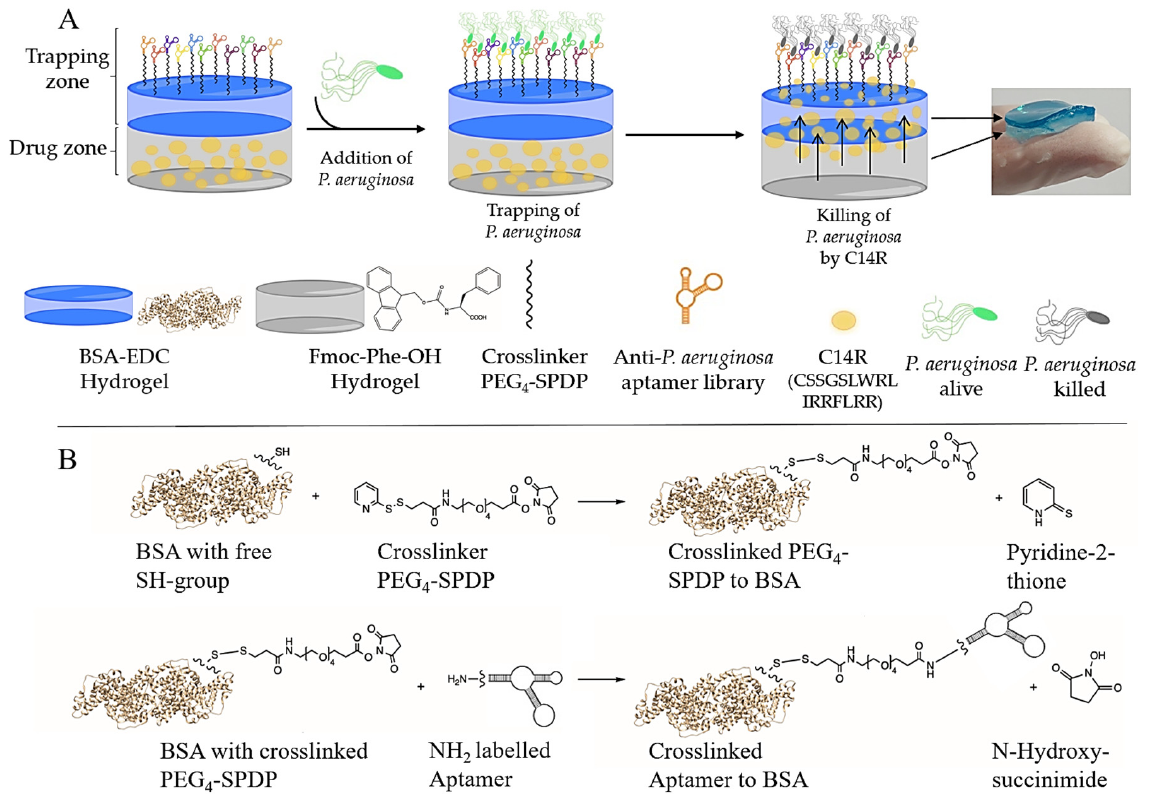
Figure 1. General concept of the P. aeruginosa -specific AA-EraGel pathogen killing trap. ( A ) The general concept of the hydrogel trap is in a first step to immobilize the bacteria using the specific aptamer library for P. aeruginosa and then to kill the immobilized bacteria with the AMP which is continuously released from the hydrogels. The upper hydrogel consists of bovine serum albumin (BSA) chemically crosslinked with EDC (1-ethyl-3-(3-dimethylaminopropyl)carbodiimide) and then functionalized with a PEG 4 -SPDP (Tetraethylenglycole-Succinimidyl 3-(2-Pyridyldithio)propionatend, an NH 2 -labeled aptamer library specific for P. aeruginosa , to irreversibly immobilize the bacteria on the surface of the hydrogel. ( B ) The reaction starts with a displacement reaction of the sulfhydryl-reactive molecule (2-pyridyldithio group) of PEG 4 -SPDP and the free SH group of the BSA–EDC hydrogel. In the next step, the NH 2 -labeled aptamer reacts with the amine-reactive portion ( N -hydroxysuccinimide) of PEG 4 -SPDP via an NHS ester reaction. The bottom hydrogel consists of Fmoc-phe-OH ( N -(Fluorenyl-9-methoxycarbonyl)-L-phenylalanin) and phosphate buffer loaded with a specific AMP against P. aeruginosa , here